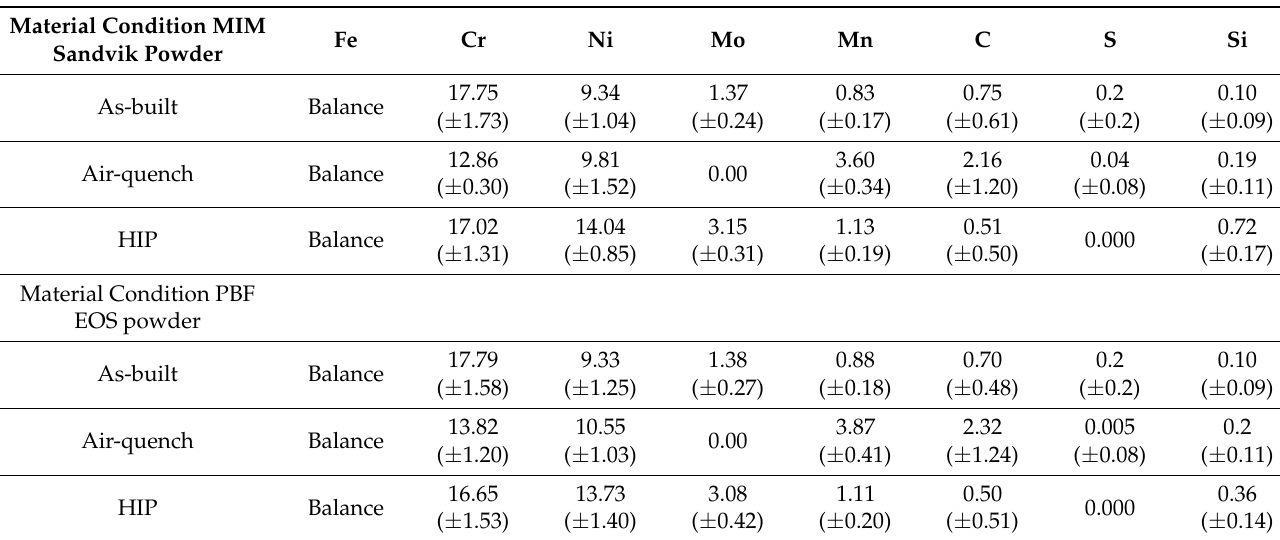
Table 1. Material composition (% by mass) before, after air quench, and the HIP treatment, averaged from the data of three samples. Values in the bracket indicate standard